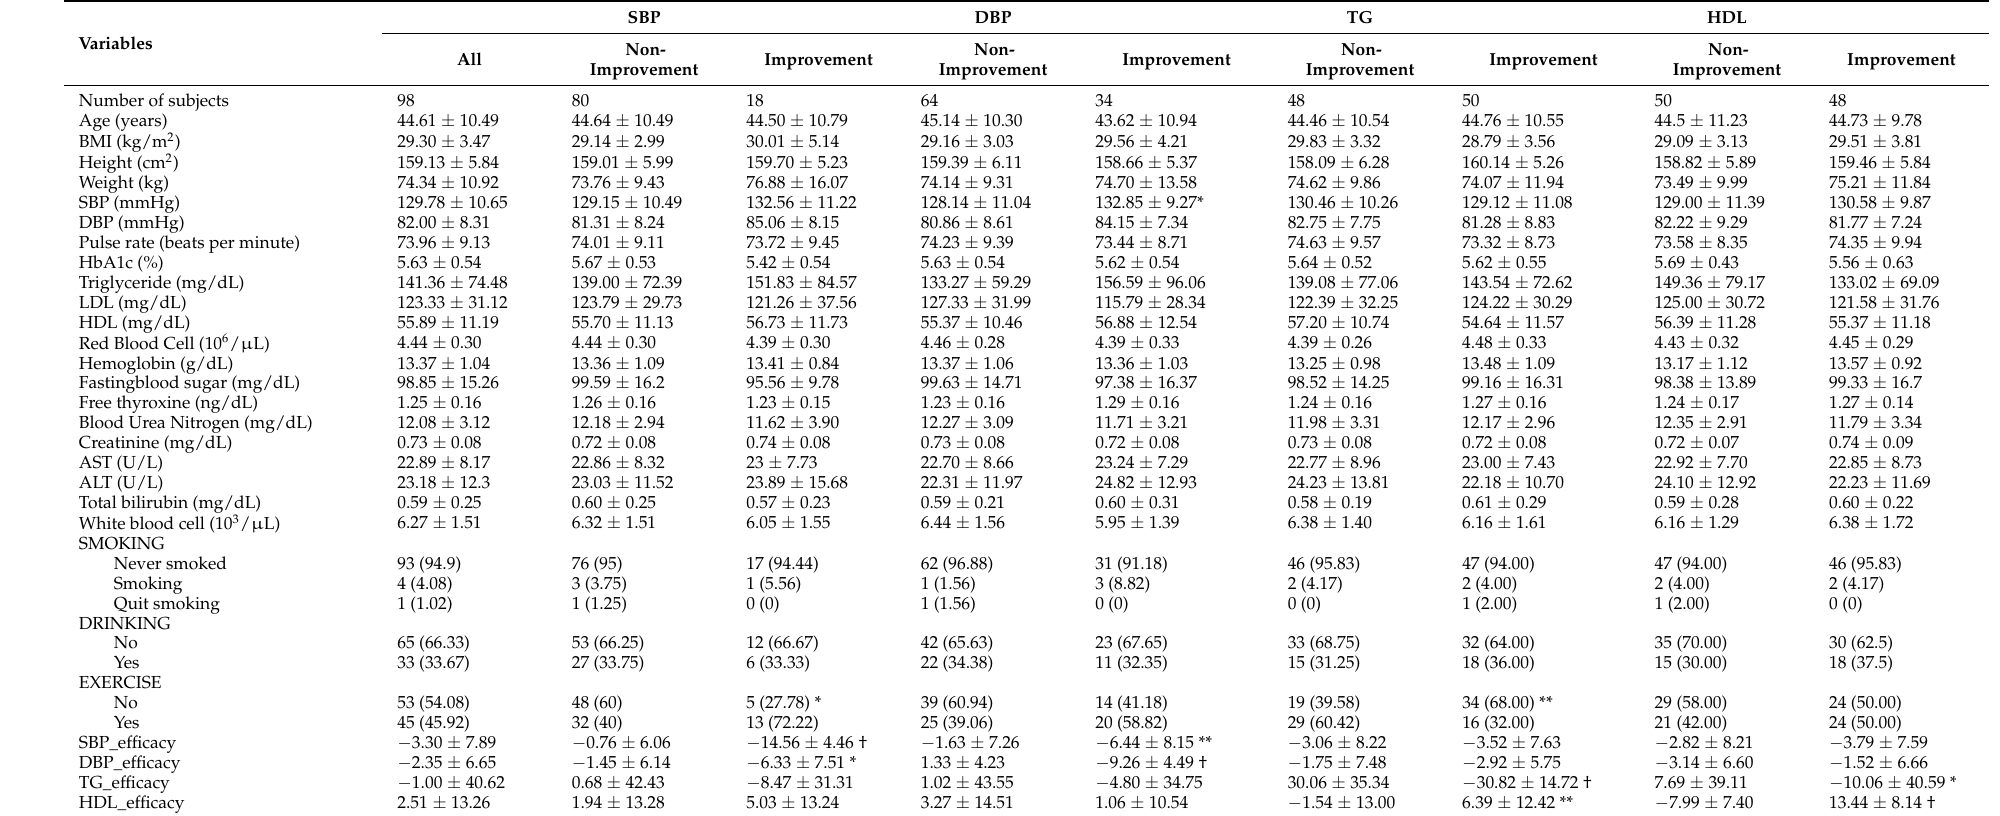
Table 1. Baseline characteristics of the study subjects according to metabolic risk